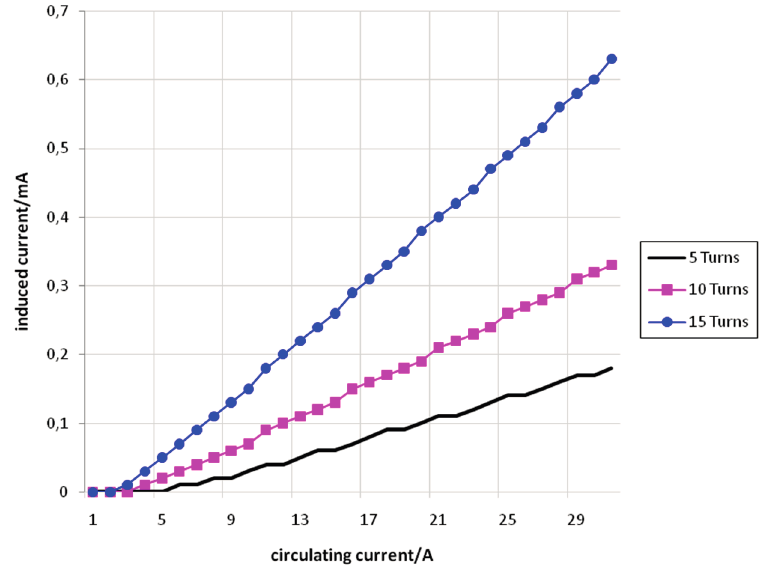
Figure 8. I f versus I i for the conductor of 2.5 mm 2 with 5 turns (black), 10 turns (pink), and 15 turns